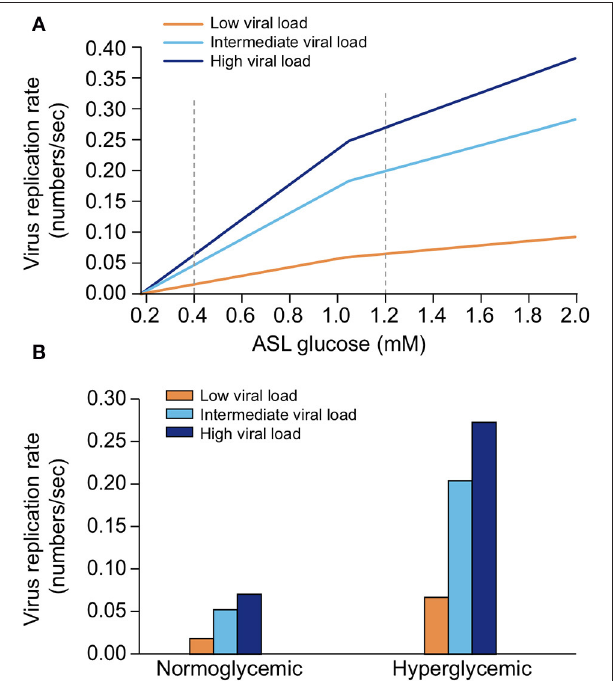
FIGURE 24 | Simplified computational model of the number of virions in the epithelium as a function of glucose concentration in the ASL and viral load at time of a sneeze stimulus. (A) The dynamic of the viral propagation, in case of three different viral load (low, intermediate, and high, see section Methods), as a function of a sweep over a range of glucose concentrations in ASL was computed and represented. (B) The number of virions in a normoglycemic (0.4mM ASL glucose) or hyperglycemic case (1.2mM ASL glucose) after a low, intermediate, or high viral load at time of infection are deduced from the model [see dashed line in (A )] and plotted. We set a hypothetical “severity threshold” for an absolute value > 1 × 10 4